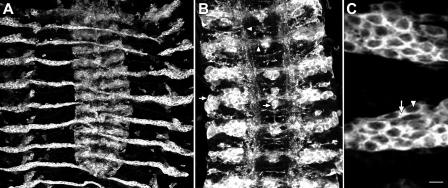
Spastin Protein Localizes to the Cytoplasm(A) In embryo “fillets” in which Spastin overexpression is driven by the engrailed-GAL4 driver, a polyclonal antibody, pAb1239, generated against the C-terminal half of Spastin (aa 380–758) recognizes the characteristic striped pattern of Engrailed cells. Anterior is up; the CNS is the structure in the center, and the lateral epithelial stripes extend to either side.(B) An enlarged view of the CNS shows Spastin protein in these embryos localizing to neuronal cell bodies (arrow indicates the ventral unpaired midline [VUM] neurons), as well as in commissural and longitudinal axons (arrowheads).(C) A high-magnification view of the Spastin-positive epithelial cells shows that the protein fills the cytoplasm (arrow), and is excluded from the nucleus (arrowhead).Scale bar: (A) 25, (B) 10, and (C) 6.5 μm.